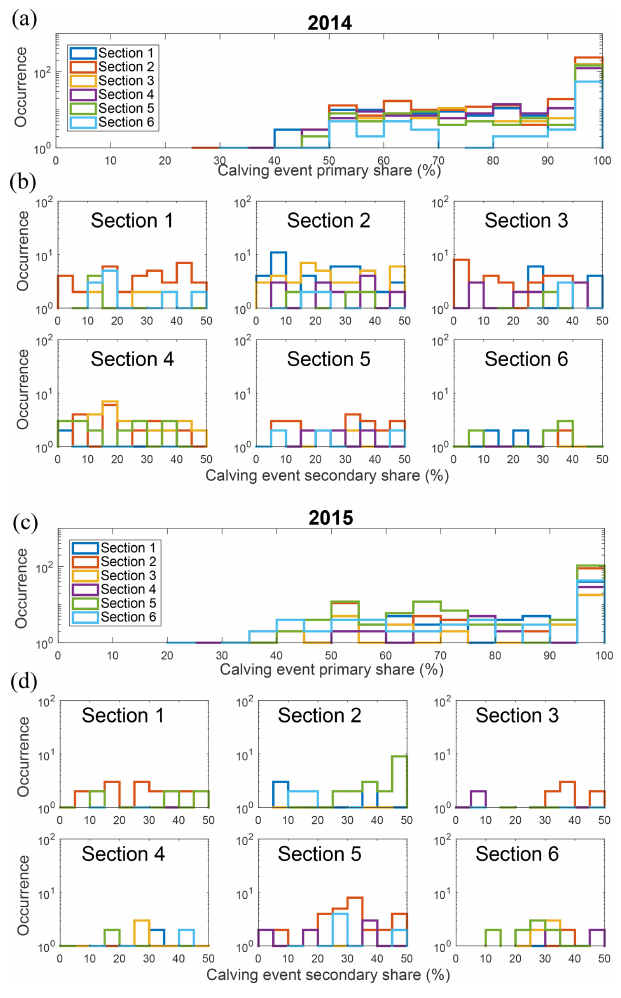
Figure 12. Size proportion histogram of the major calving event size per image for (a) 2014 and (c) 2015. Size proportion histogram of the secondary calving event size per image and per section for (b) 2014 and (d) 2015.